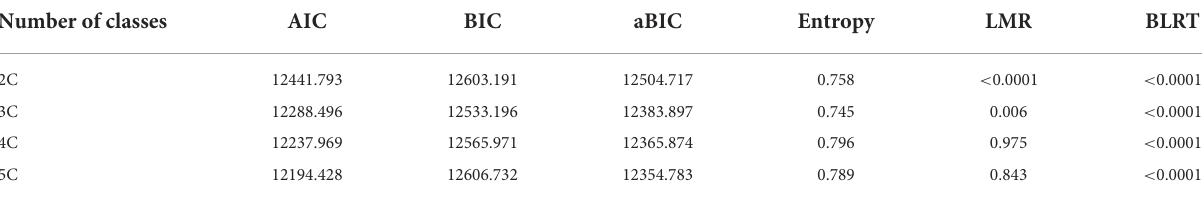
TABLE 4 Fit indices for LCA between 2 and 5